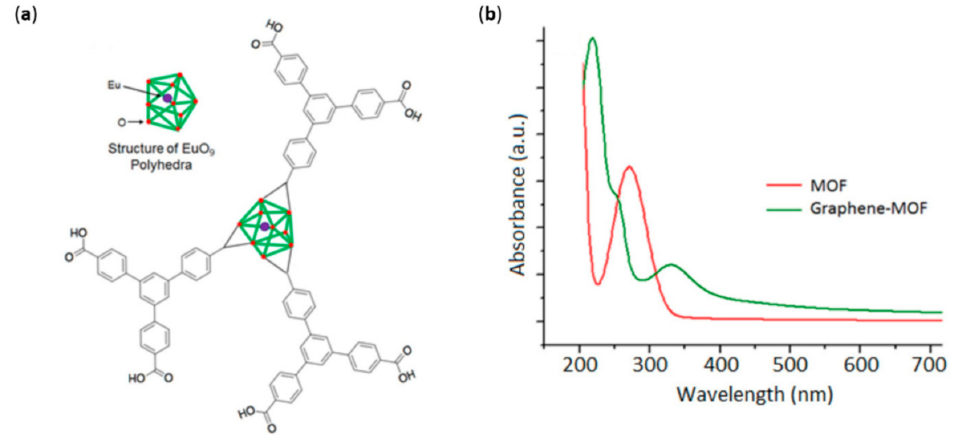
Figure 6. Structure of Eu–MOF ( a ). Absorbance profile ( b ) of the pristine MOF and the hybrid MOF–graphene. Reproduced from [61] with the permission of